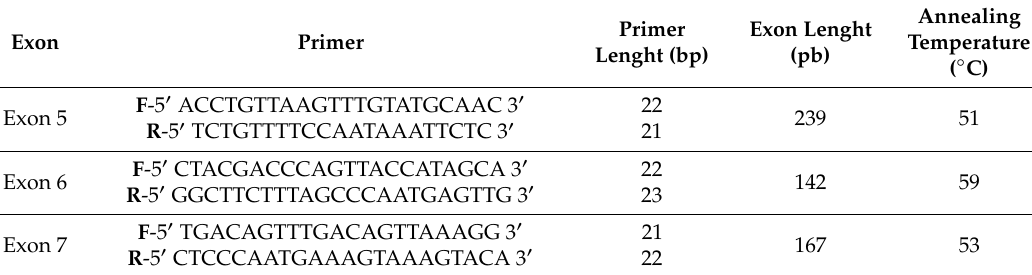
Table 9. Primers used for PTEN